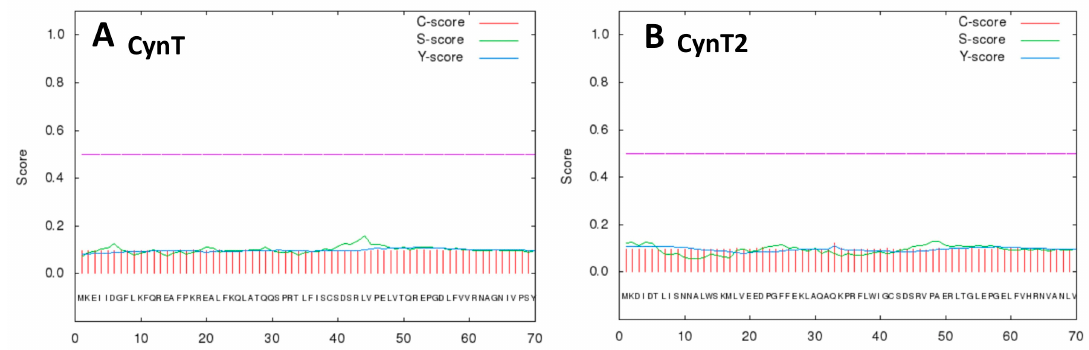
Figure 1. SignalP 4.1 graphical results obtained using the two β -CA polypeptide chains encoded by the Escherichia coli genome. Legend: Panel ( A ), CynT; Panel ( B ), CynT2; X-axis, the first 70 amino acid residues at the amino terminus of the polypeptide chain; Y-axis: C-score (red line), raw cleavage site score; S-score (green line); signal peptide score; Y-score (blue line), the combined cleavage site score. The violet line indicates the threshold value of 0.5.